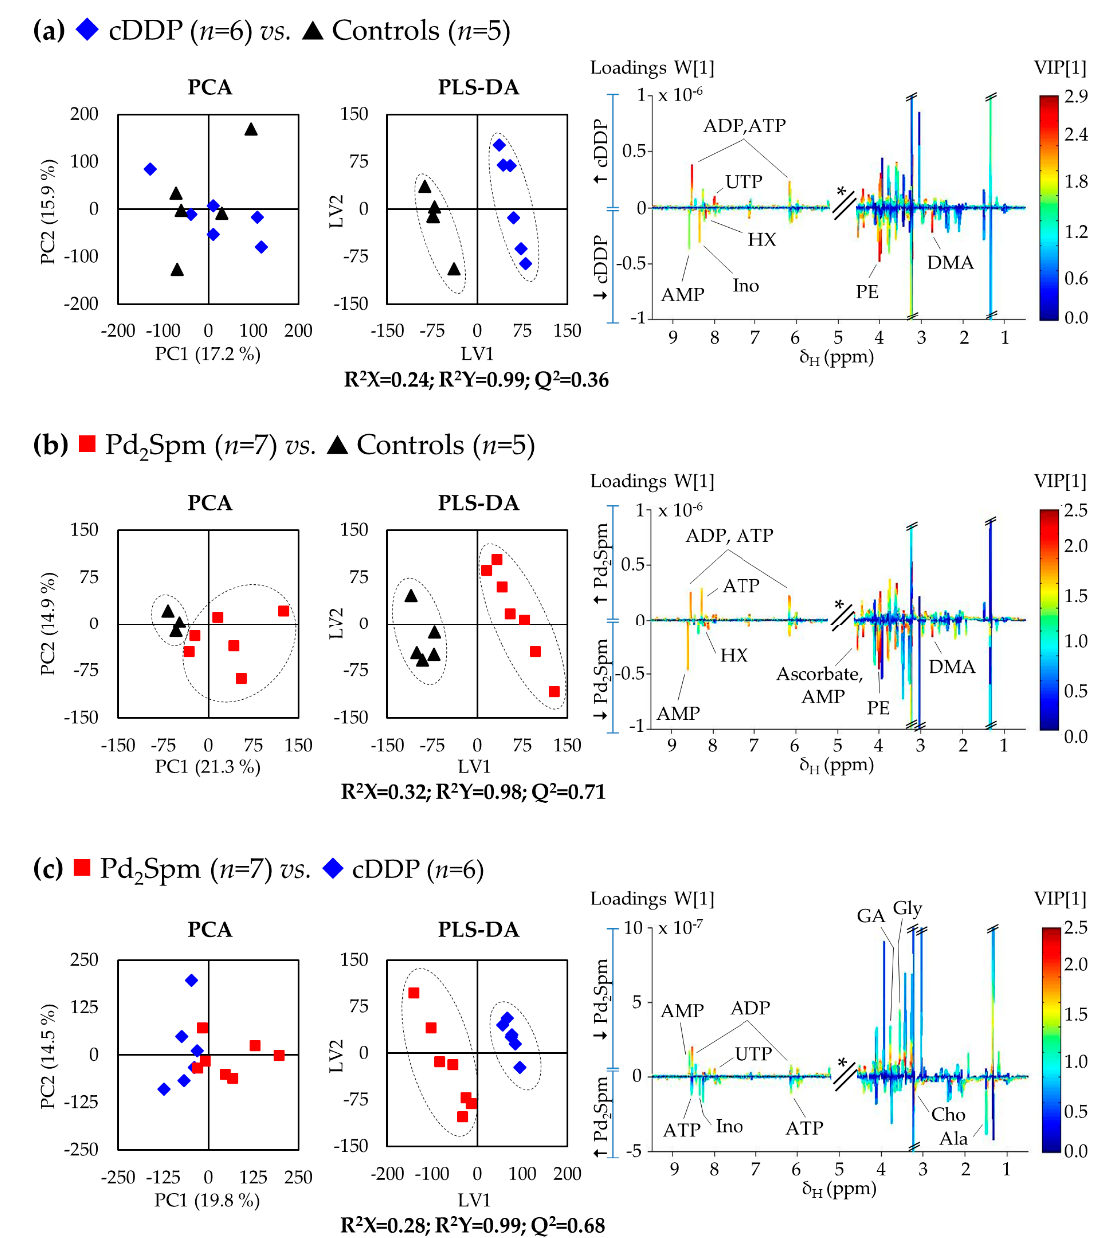
Figure 3. Score scatter plots of PCA (left) and PLS-DA (middle) models obtained for 1 H NMR spectra of aqueous extracts of tumors from MDA-MB-231 CDX mouse model, obtained for each pairwise analysis: ( a ) cDDP vs. Controls; ( b ) Pd 2 Spm vs. Controls; and ( c ) Pd 2 Spm vs. cDDP. LV1 loadings plots (right) from the correspondent PLS-DA model are colored according to variable importance to projection (VIP) and exhibit the assignment of main peaks (*: cut-off spectral region corresponding to the water resonance). Abbreviations: DMA, dimethylamine; GA, guanidine acetate; HX, hypoxanthine; PE, phosphoethanolamine; UTP, uridine triphosphate. Other abbreviations are defined in the caption of Figure